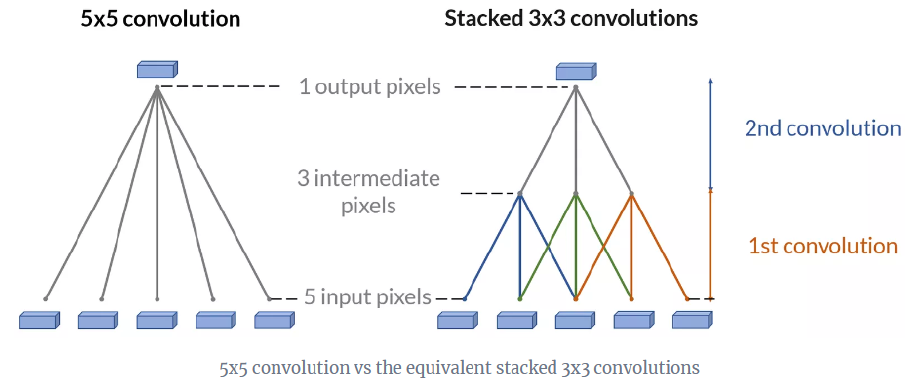
Figure 5. If an input has 5 pixels, a stacked 3 × 3 convolutions reaches the same number of output pixels as a single 5 × 5 convolution. However, it requires only 18 variables to be trained (3 × 3 × 2) instead of 25 (5 × 5)